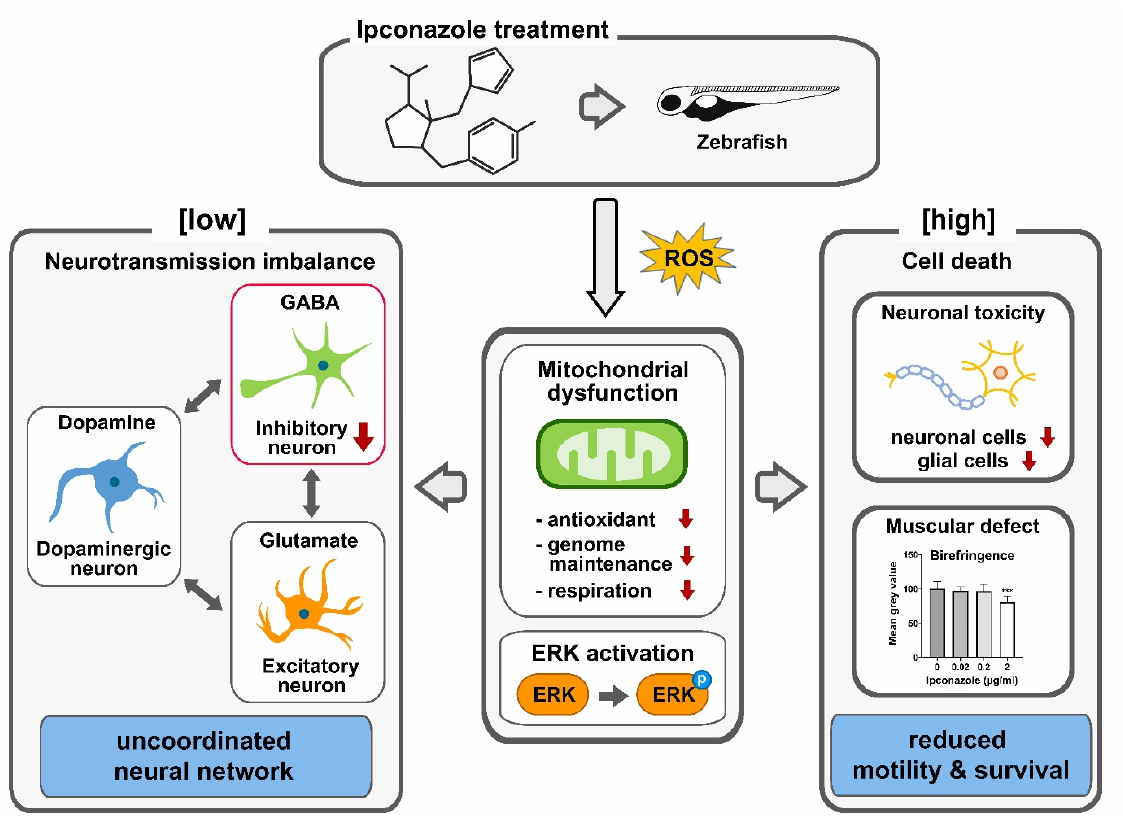
Figure 6. Potential mechanism of neurodevelopmental toxicity of ipconazole pesticide in zebrafish. The zebrafish embryos treated with ipconazole generate ROS and show evidence of dose-dependent mitochondrial dysfunction and ERK1/2 activation. Ipconazole specifically inhibited the development of GABAergic inhibitory neurons at low doses. In contrast, glutamatergic and dopaminergic neurons remained unaffected, possibly disrupting the interplay among the major neurotransmission systems and uncoordinated neural functions in the central nervous system. High concentrations of ipconazole cause cell death in neuronal and muscle development, reducing the motility and survival of embryos. *** p < 0.001.